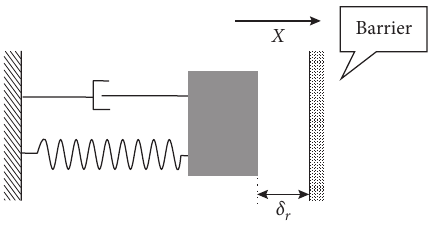
Figure 1: Schematic of a vibrating system with a barrier on the right